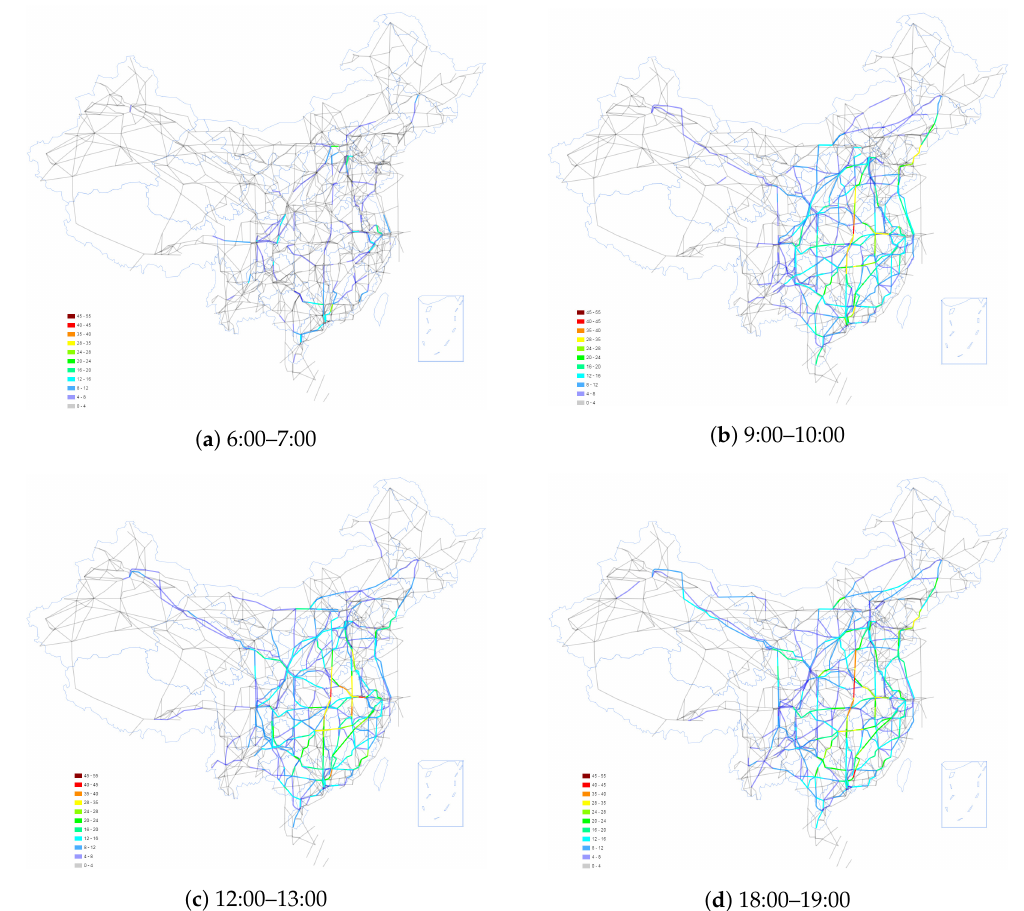
Figure 7. The traffic flows distributed on air route network at different time